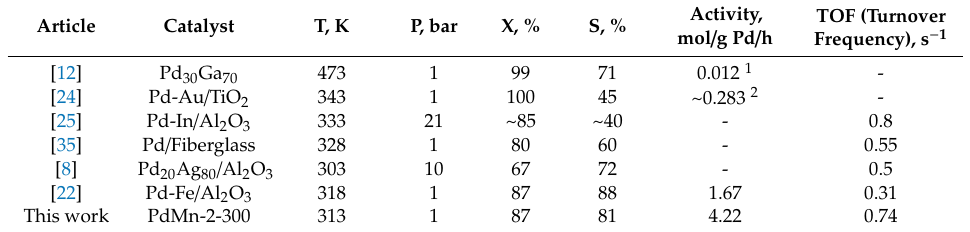
Table 2. Comparative characteristics of the best Pd-containing catalysts in acetylene